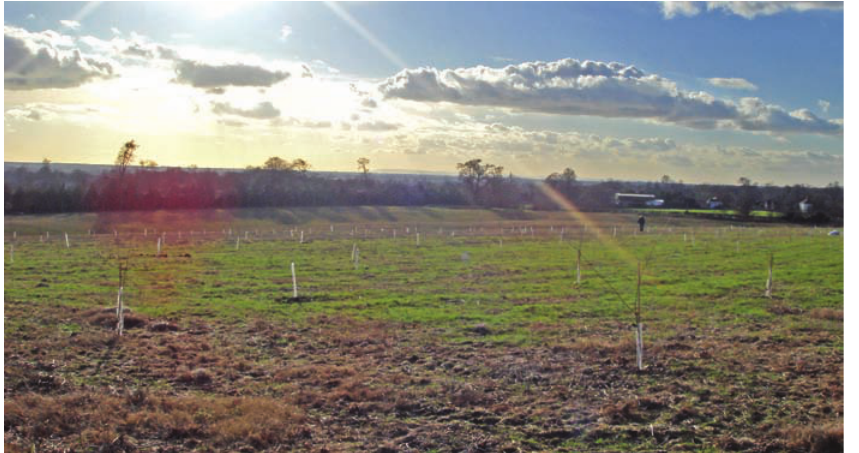
Figure 5 Tree planting in the top field at Boxgrove, looking southwest. The Isle of Wight is visible in the background